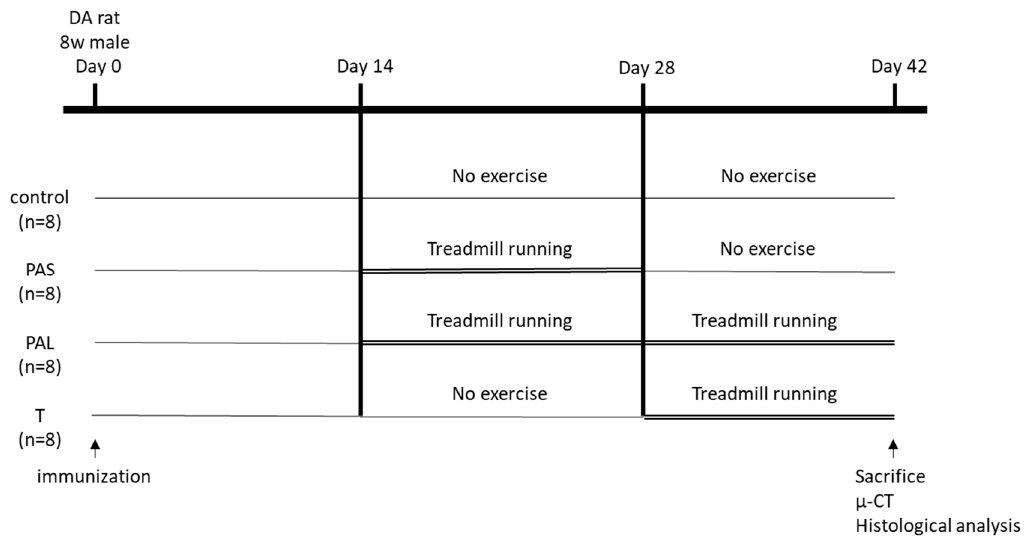
Figure 6. Experimental protocols. Eight-week-old male Dark Agouti rats were randomly divided into four groups: control, PAS, PAL, and T groups. PAS ( n = 8), run from day 14 to 28; PAL ( n = 8), run from day 14 to 42; and T ( n = 8), run from day 28 to 42.